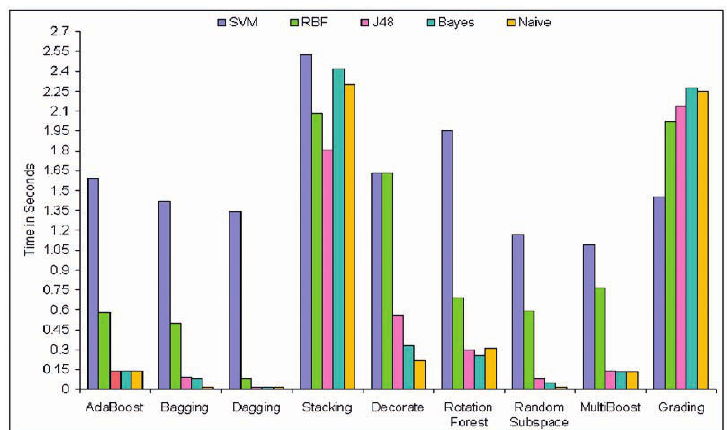
Figure 5. Time taken in seconds of cascaded k -means C ensembles with five base classifiers for PIDD (using D2: processed